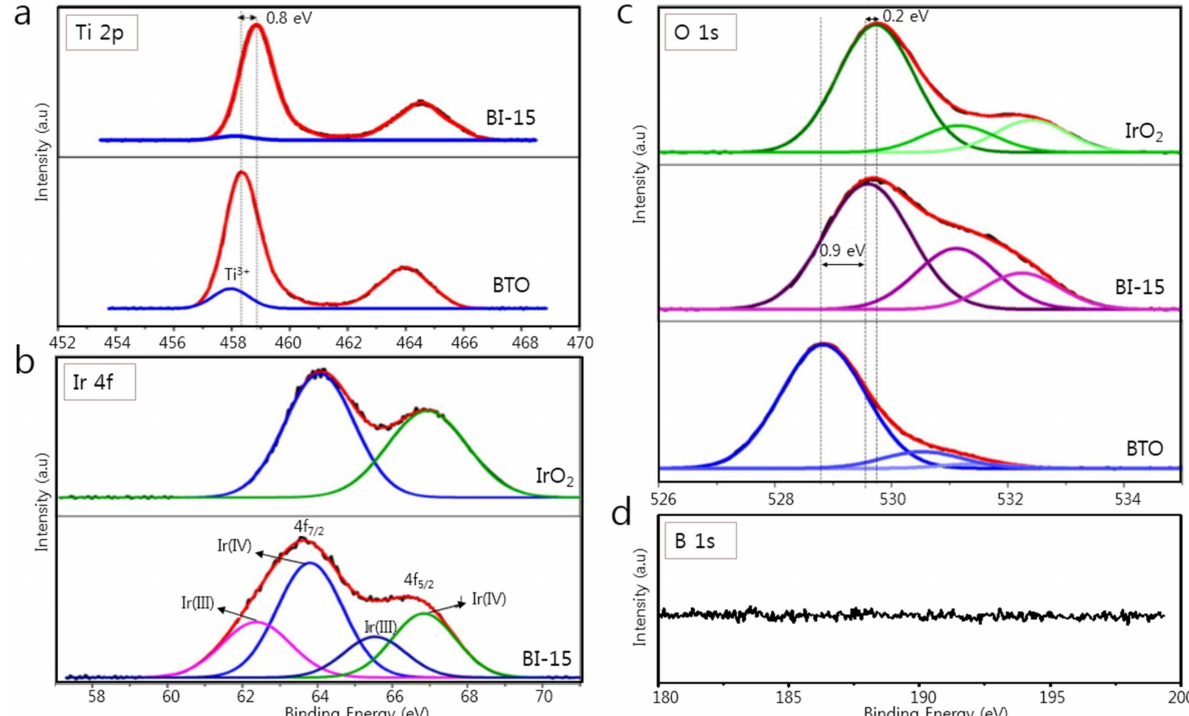
Figure 2. XPS analysis of BTO, IrO 2, and IrO 2 -BTO samples: ( a ) Ti 2p spectra; ( b ) Ir 4f spectra, ( c ) O 1s spectra, and ( d ) B1s